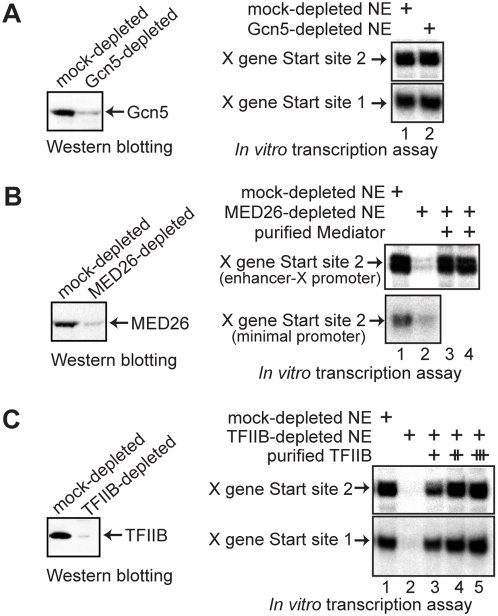
Transcription from X mRNA Start site 2 requires MED26-containing mediator and TFIIB but not Gcn5.(A) HeLa cell nuclear extract (NE) was immunodepleted with control or anti-Gcn5 antibody. The depleted NEs were then tested for the level of depletion by western blotting and for X gene transcription activity from the two start sites using the enhancer-X promoter construct. (B) HeLa NE was immunodepleted with control or anti-MED26 antibody. The depleted NEs were then tested for the level of depletion and for X gene Start site 2 transcription activity using either the enhancer-X promoter construct or the minimal promoter construct in the absence (lane 2) or presence (lanes 3 and 4) of mediator complexes purified from P.5 (lane 3) or P1.0 (lane 4) phosphocellulose fractions. The response of the transcription from Start site 1 has been reported [6]. (C) HeLa NE was immunodepleted with control or anti-TFIIB antibody. The depleted NEs were then tested for depletion and for X gene transcription activity from the two start sites using the enhancer-X promoter construct in the absence (lane 2) or presence (lanes 3–5) of the purified TFIIB (10, 30, or 100 ng).